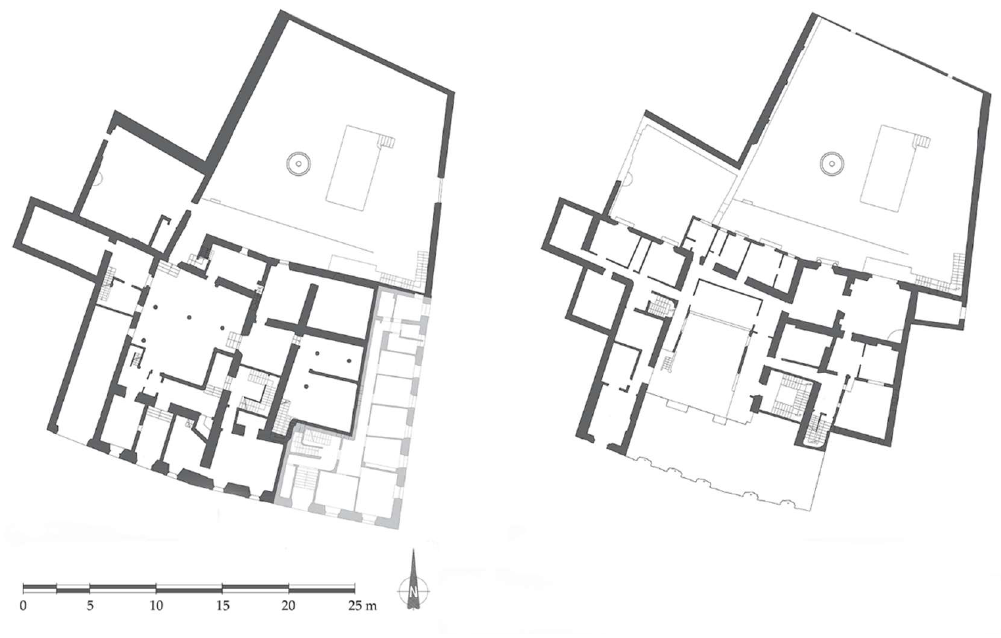
Figure 17. Ground floor plan and first floor plan.